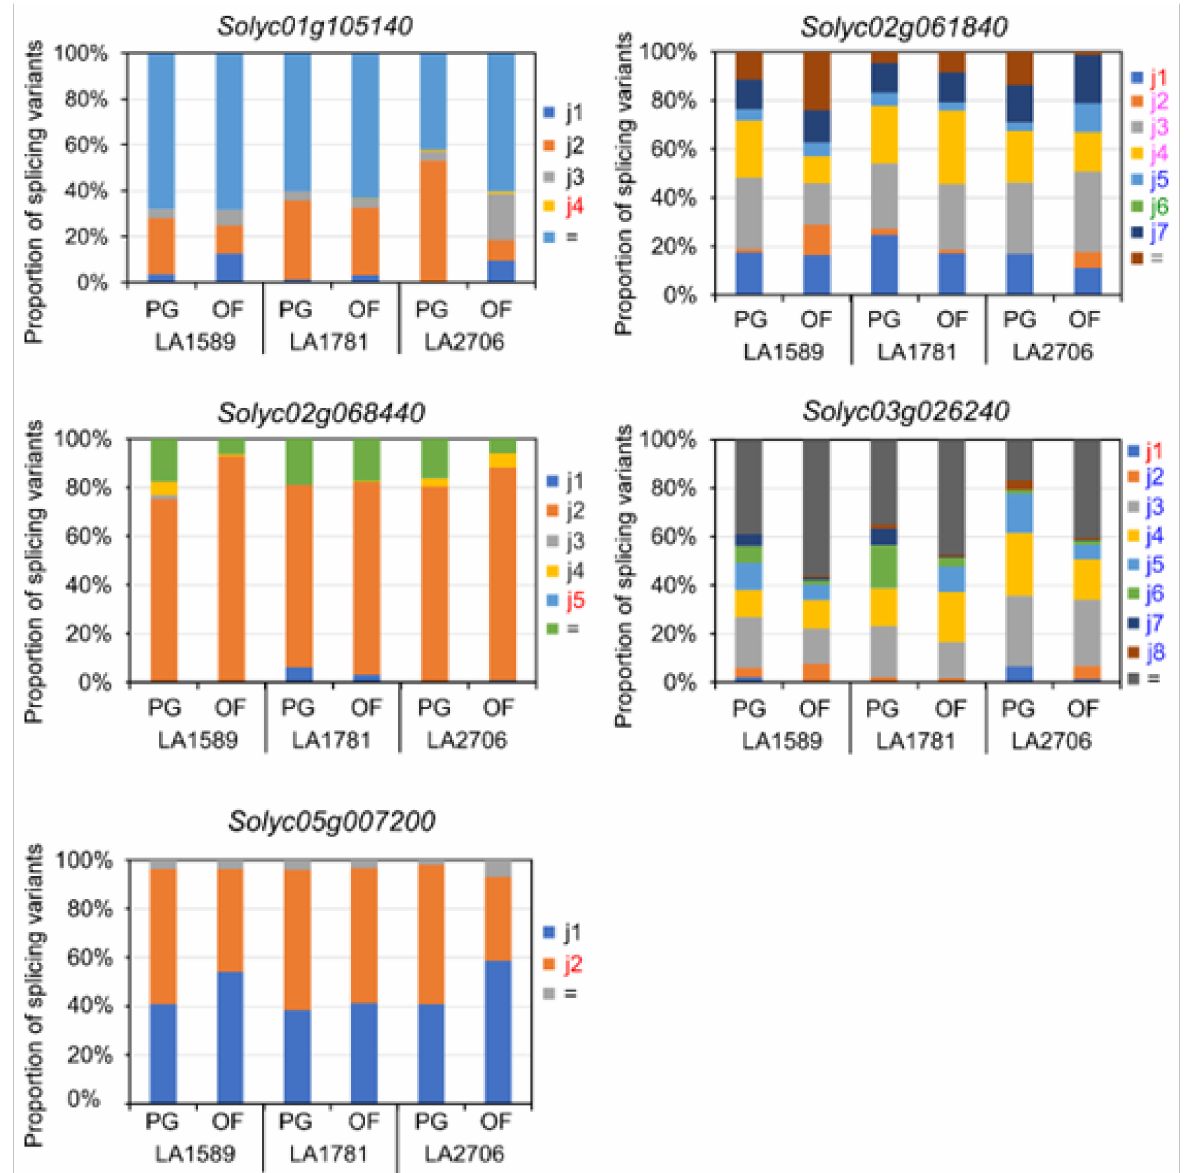
Figure 5. Expression levels of splice variants of five representative DAGs encoding splicing factors. The histograms show expression proportion of each splice variant. “=” represents an isoform the same as annotated. “j” represents a novel splice